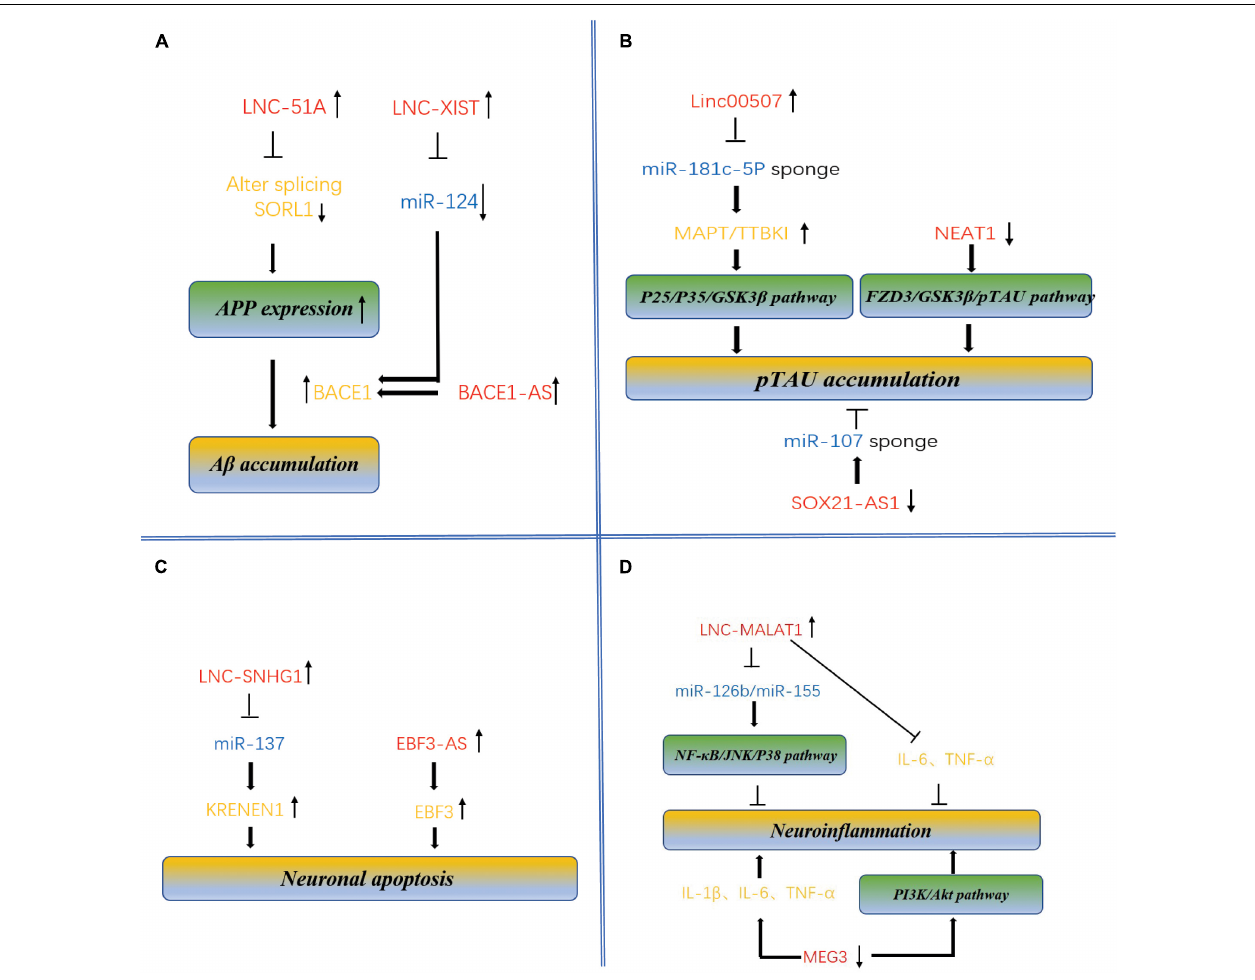
FIGURE 2 | Molecular mechanism of lncRNAs and miRNAs mediated accumulation of A β plaques and pTAU, neuronal apoptosis and neuroinflammation in AD. (A) Dysregulation of BACE1-AS, XIST, and lnc-51A leads to overproduction of A β , contributing to pathogenesis of AD. BACE1-AS, XIST, and lnc-51A are highly expressed in brains of the AD patients and APP transgenic mice, regulates the expression of BACE1 mRNA and increases the production of A β . Enhanced expression of lnc-51A in AD patient altered splicing mode of SORL1, thereby causing damage to APP processing and leading to promotion of the A β deposition. XIST and BACE1 are targets of miR-124 because there is a binding site in these two targets. The XIST-miR-124-BACE1 axis regulates the expression of BACE1 in AD, determining the formation of A β . (B) LncRNAs regulate pTAU accumulation. Linc-00507, SOX21-AS1, and NEAT1 have been characterized to be involved in Tau hyperphosphorylation. Significantly upregulated expression of linc-00507 downregulates miR181c-5p, thereby elevating the levels of MAPT and TTBK1 and consequently enhancing hyperphosphorylation of tau protein by activating P25/P35 /GSK3 β signaling pathway. On the other hand, silencing of SOX21-AS1 could attenuate the level of Tau phosphorylation mediated by miR107 inhibition. Similarly, downregulation of NEAT1 promoted Tau protein phosphorylation via FZD3/GSK3 β / p-tau pathway. (C) LncRNAs regulate neuronal apoptosis. LncRNA-SNHG1, lnc-EBF3-AS, and MEG3 have been identified to be involved in neuronal apoptosis, linking to pathogenesis of AD. SNHG1 silencing inhibited miR-137, therefore repressing KRENEN1 expression and increasing cell viability and inhibiting apoptosis. was maladjusted in late-onset AD patients (Magistri et al., 2015), its upregulation of lnc-EBF3-AS stimulated the expression of EBF3, thus promoting the apoptosis of neurons in AD. (D) LncRNAs regulate neuroinflammation. Some lncRNAs, and miRNAs such as MALAT1 and MEG3, have been identified to be involved in the neuroinflammation. Upregulation of MALAT1 downregulated expression several inflammation-related miRNAs, such as miR-125b and miR-155. These miRNAs target to the genes involved in many signaling pathways, such as JAK signal transduction and activator of transcription (STAT) pathway, nuclear factor –kB (NF-kB) signaling pathway, JNK pathway and p38 signaling pathway, thereby inhibiting neuroinflammation of AD. downregulated expression of MEG3 promoting the occurrence of